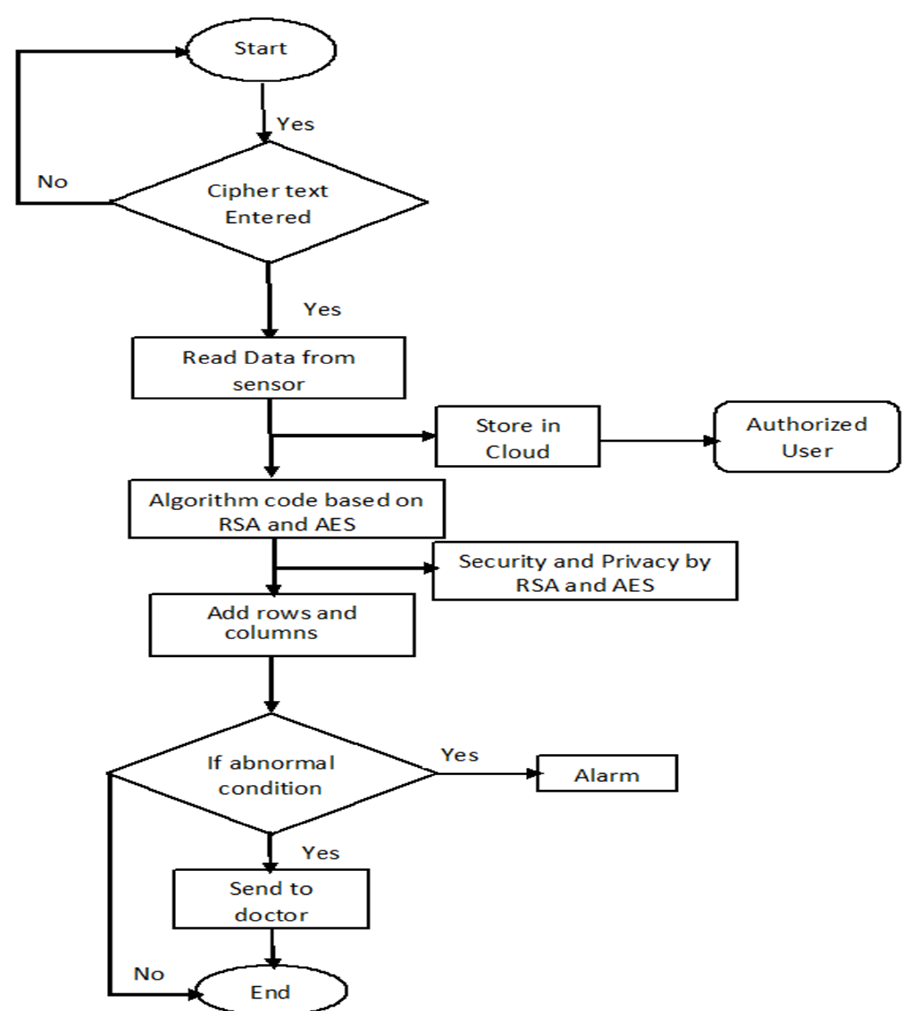
Figure 3. The proposed framework for securing medical data transmission.